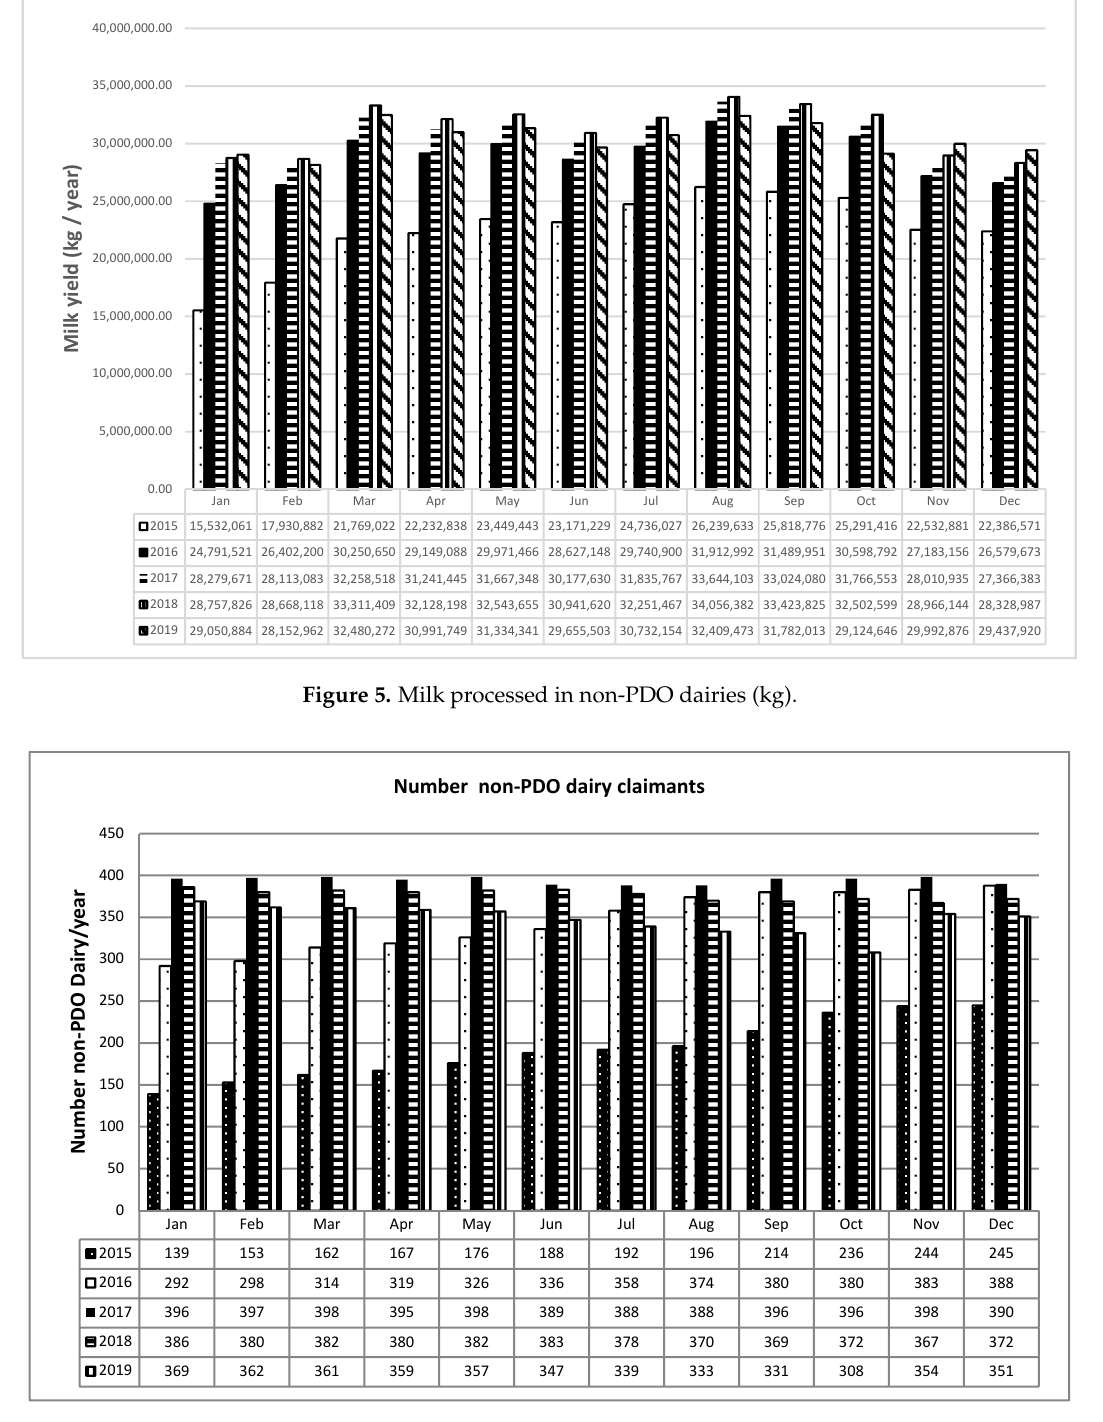
Figure 6. Number of non-PDO dairy reporters.